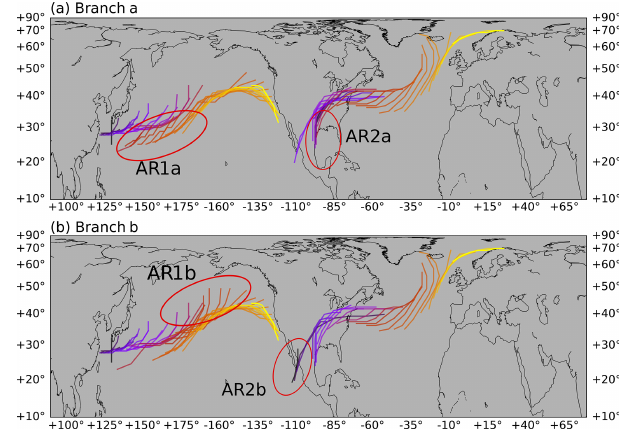
Figure 8. Tracks of two ARs obtained using the network scheme. Each of the two ARs (AR1 and AR2) has two branches (branch a and branch b) in their tracks, shown in panels (a) and (b) , respec- tively. The same color scheme as in Fig. 7 is used to represent their life cycles. The different branches of a single AR track are high- lighted in red